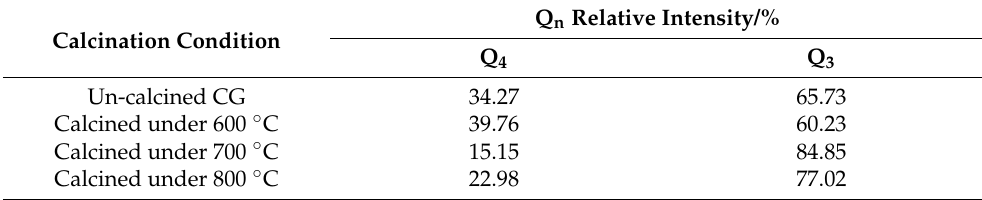
Table 3. Calculated relative intensity of 29 Si NMR with various Q n structures in the CG